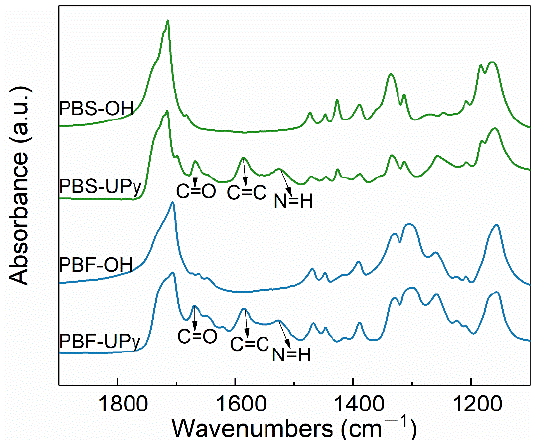
Figure 2. FTIR spectra of PBS ‐ OH, PBF ‐ OH, PBS ‐ UPy, and PBF ‐ UPy were collected at room temperature in the wavenumbers range from 1900 to 1100 cm − 1 .